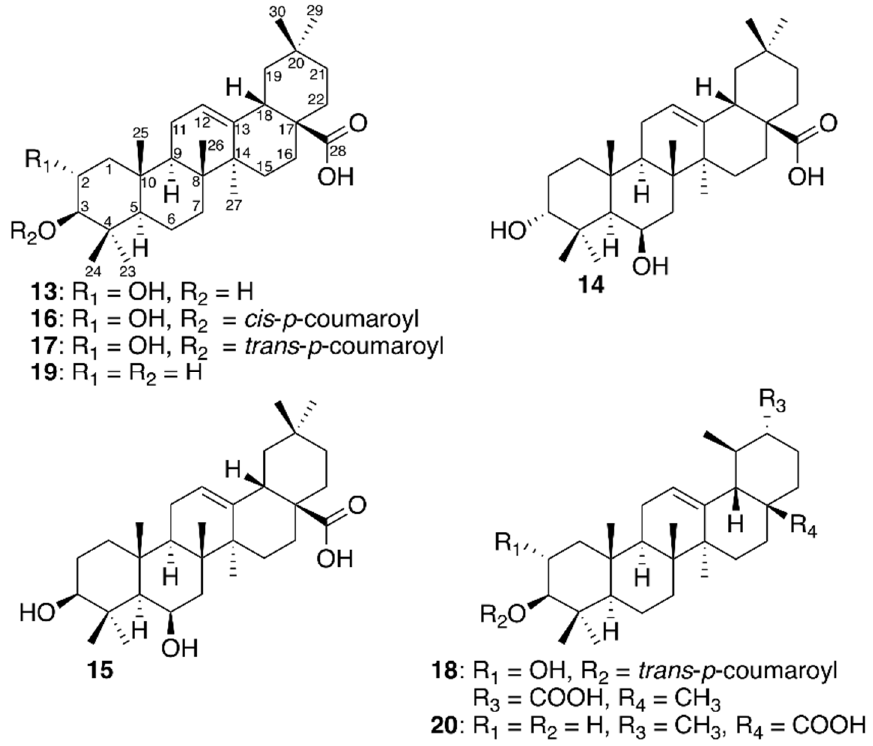
Figure 4. PTP1B inhibitors identified from fraction F1 of M. albicans .